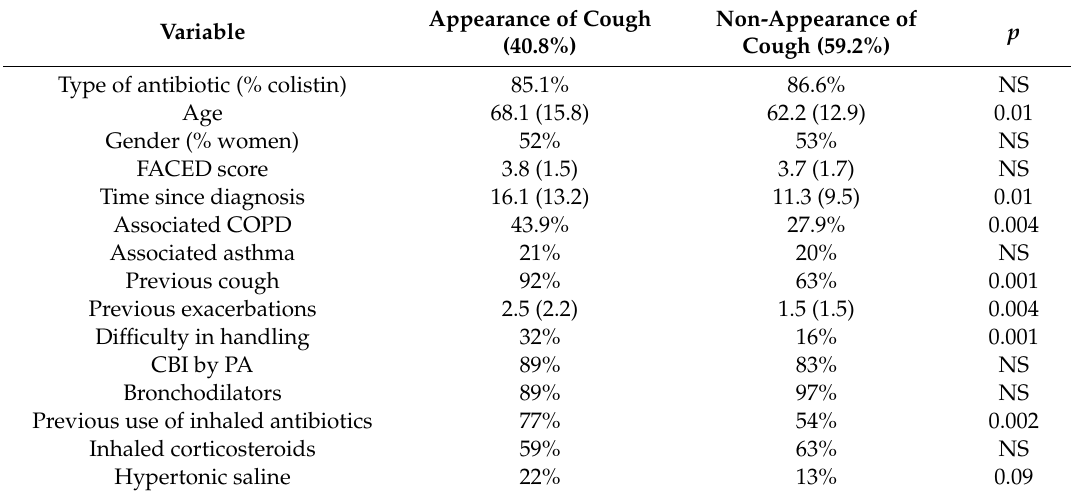
Table 5. Appearance of cough as an adverse e ff ect.